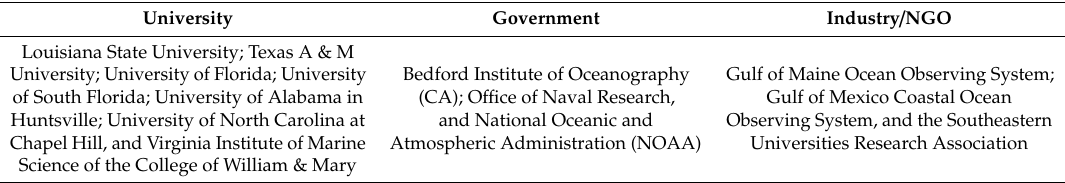
Table 1. Southeastern Coastal Ocean Observing and Predicting Program (SCOOP) collaborators and